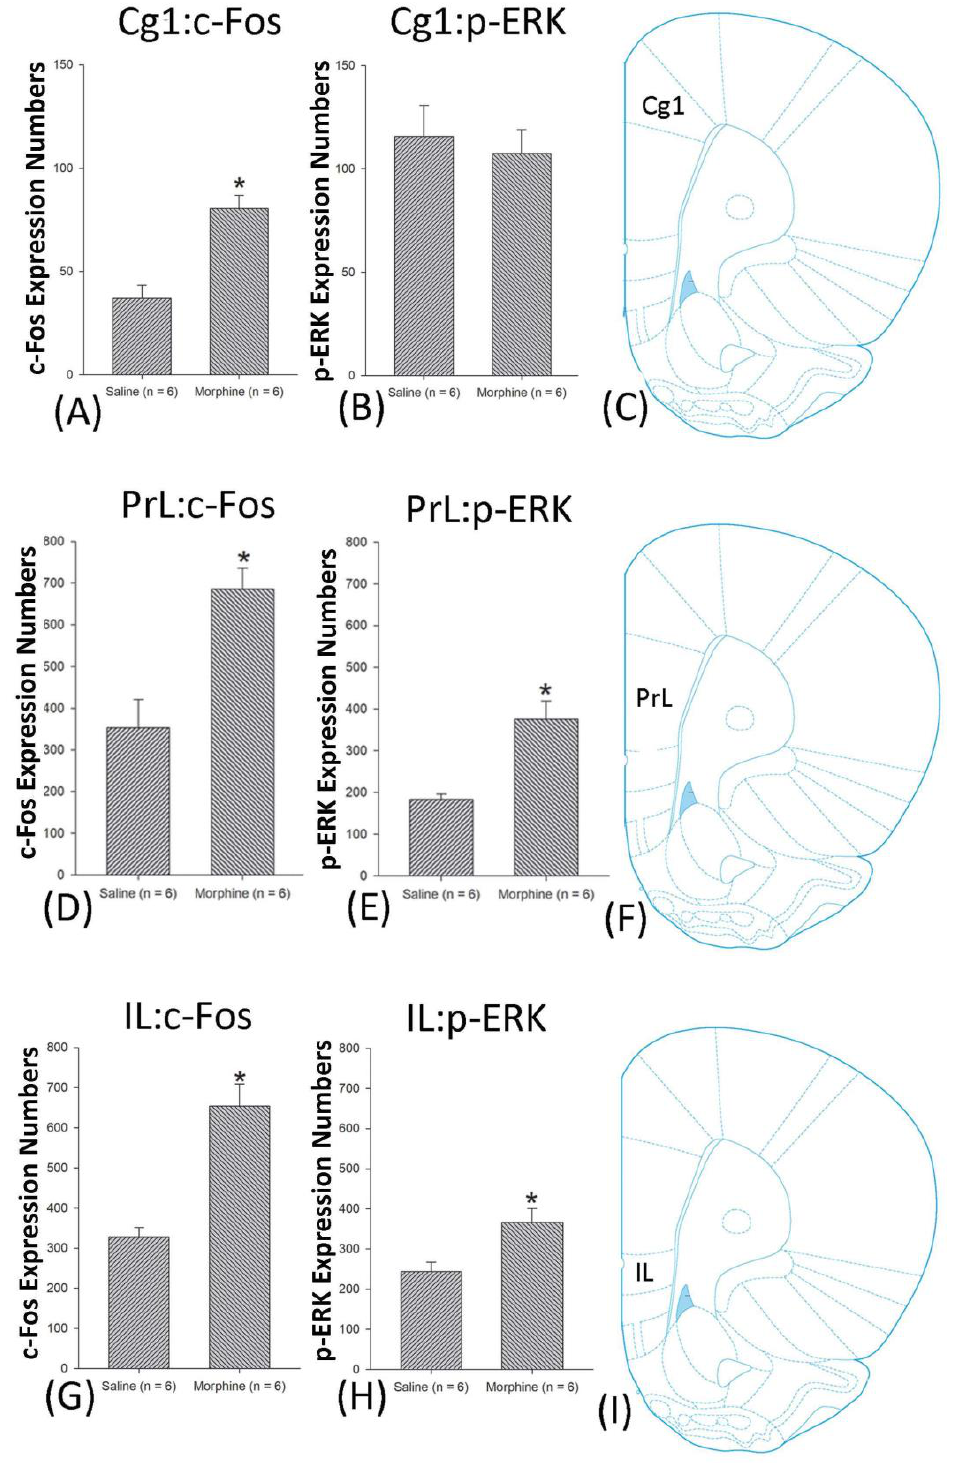
Figure 6. c-Fos or p-ERK expression in the cingulated cortex area 1 (Cg1), prelimbic cortex (PrL) and infralimbic cortex (IL) in conditioning. ( A ) c-Fos and ( B ) p-ERK expression in the Cg1, ( D ) c-Fos and ( E ) p-ERK expression in the PrL, and ( G ) c-Fos and ( H ) p-ERK expression in the IL for conditioning. ( C , F , I show a schematic representation of the Cg1, PrL, and IL. * p < 0.05 when comparing the saline and morphinegroups ( n = 6 per group).